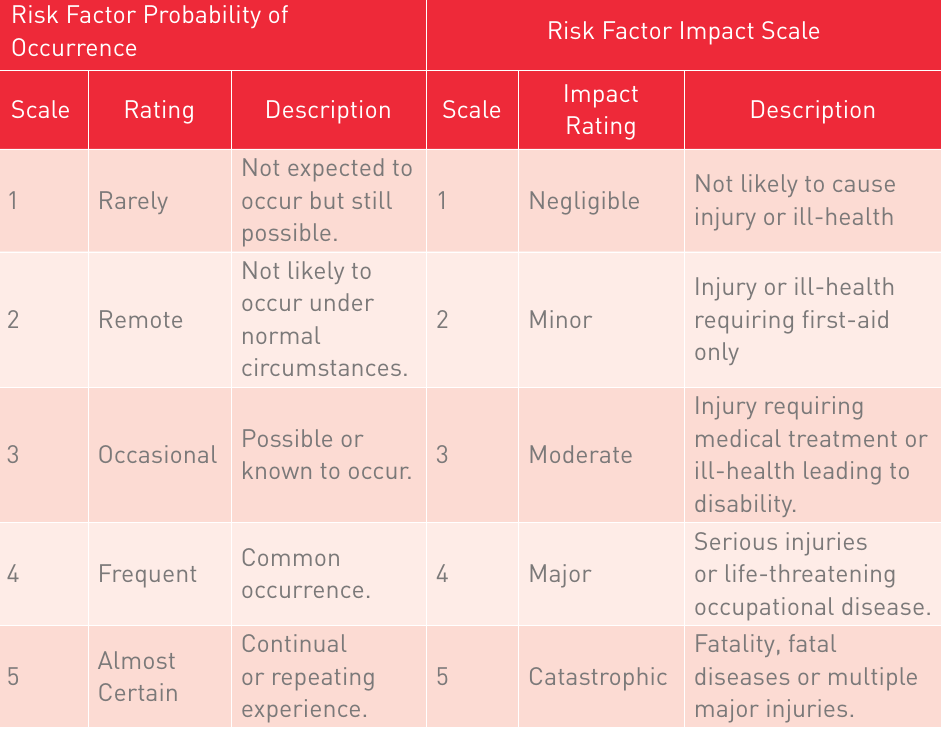
Risk factor probability of occurrence and risk factor impact